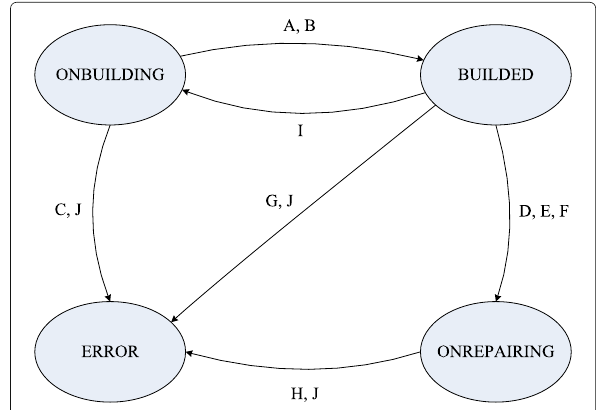
wireless channels. The channel maximum transmission rate is set to 1.5 Mbps. The transmission range of each node is set to 100 m, and the interference range is set to 200 m. During the simulation time of 100 s, one QoS CBR flow and other nine ordinary CBR flows with different sources and destinations are randomly chosen. We use dif- ferent loads, 100 kbps, 200 kpbs, 500 kbps, 1000 kbps, and 1500 kbps, to test the performance of evaluated protocols respectively. Average network throughput and average